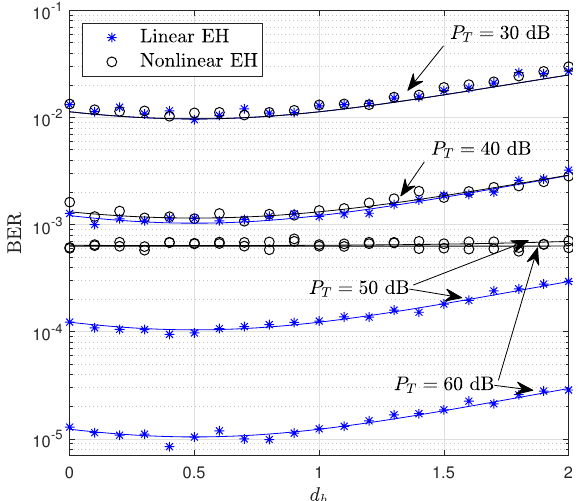
Figure 6. BER performance of the WP DH AF relaying system versus d h ( m w = m z = 2, P T = { 30,40,50,60 }